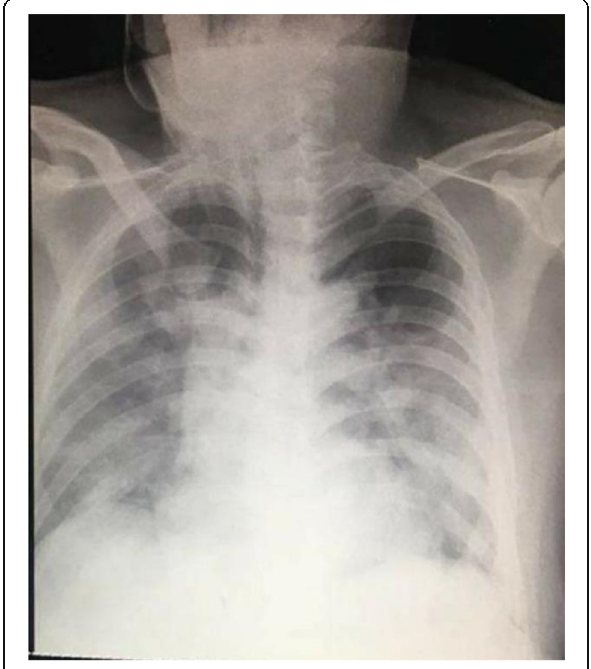
Fig. 4 Posteroanterior chest radiograph of patient 2, 27 January 2020 (illness day 10). Hazy infiltrates in both lung fields consistent with